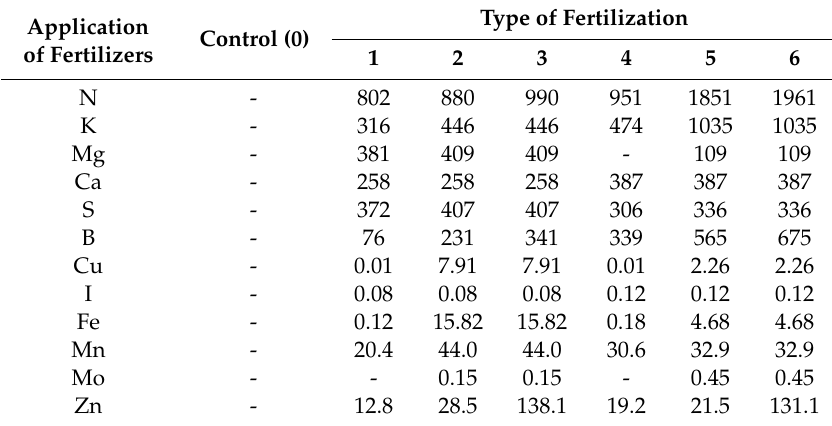
Table 7. The total doses (g ha − 1 ) of nutrients applied by foliar fertilization in the investigated treatments of sugar beet (data provided by the fertilizer producers). Type of Fertilization Application Control (0) of Fertilizers 1 N -